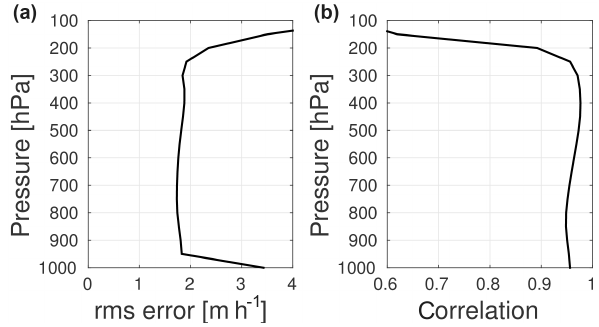
Figure 7. Time mean (a) rms error and (b) spatial correlation co- efficient between the calculated and WRF height tendency over the last 8 days of the 10-day